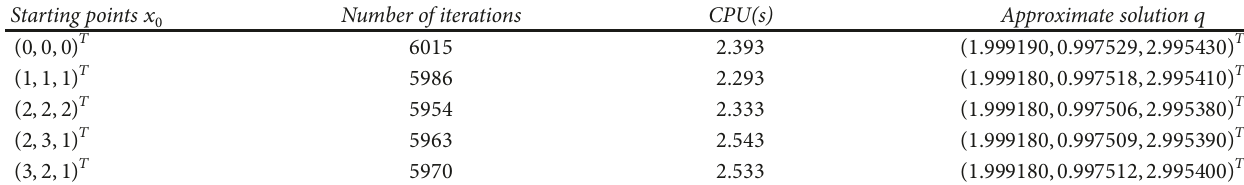
Table 1: Results for Example 1 using algorithm in Corollary